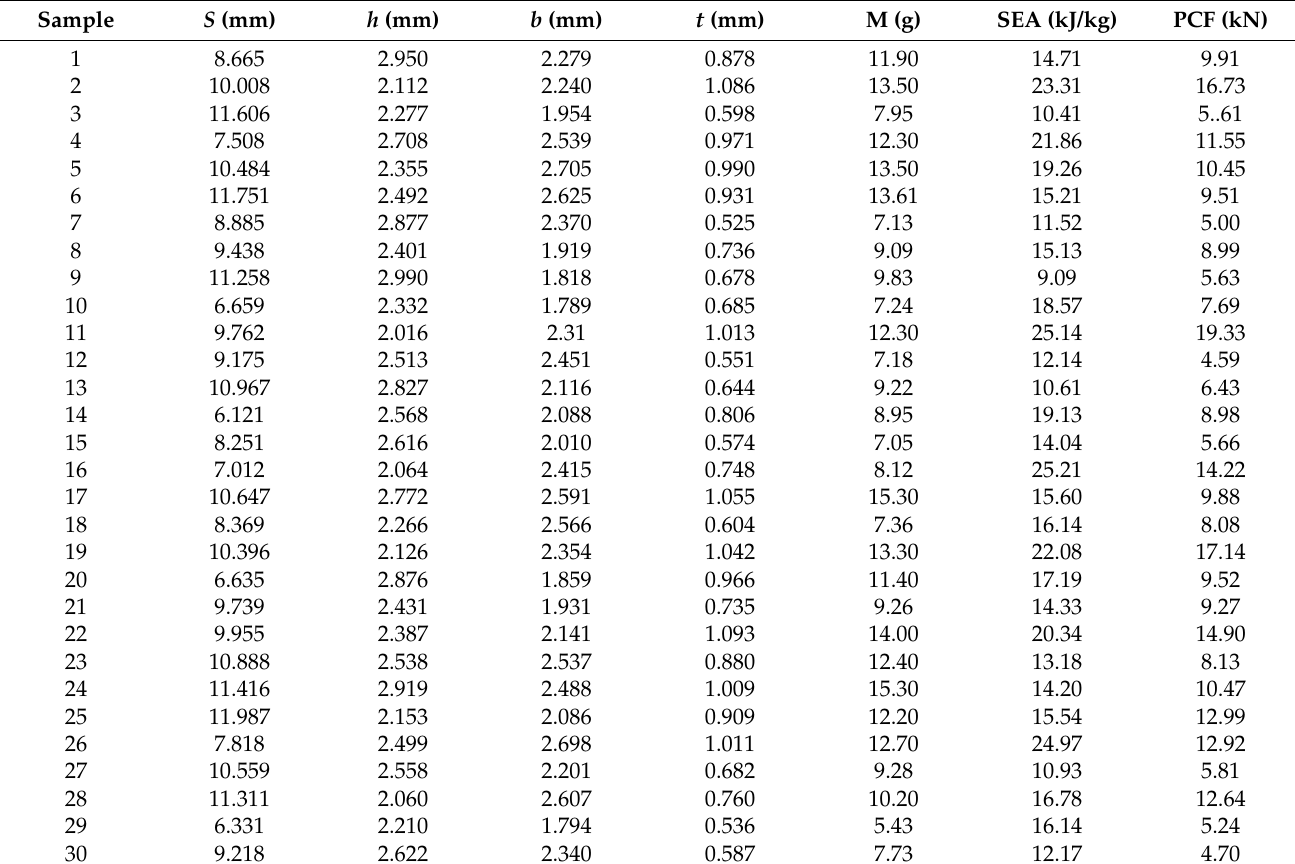
Table 6. Thirty groups of sample points and response